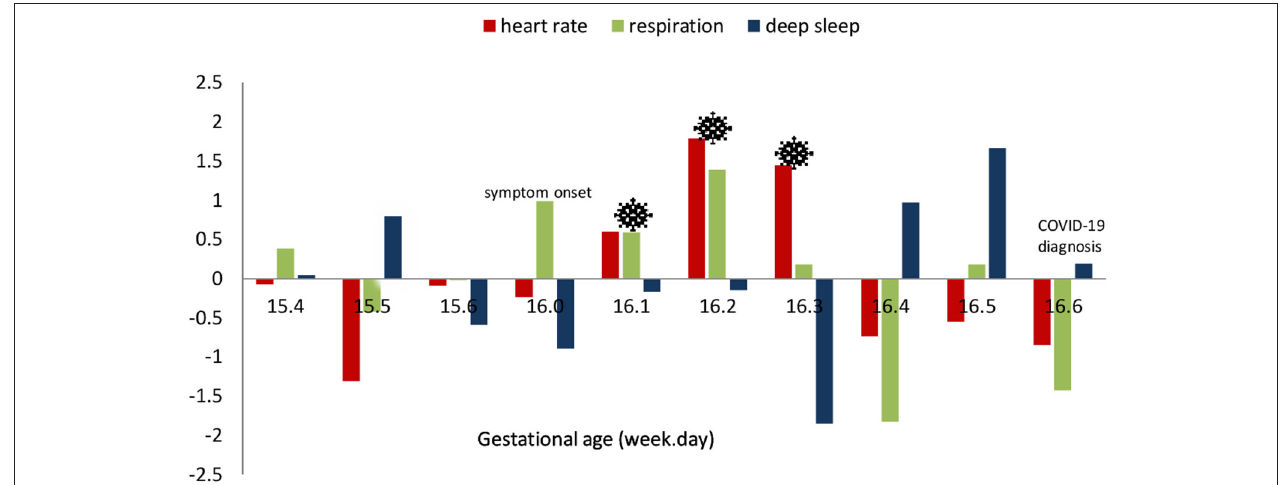
FIGURE 1 | Case I: daily standardized scores of selected physiological parameters surrounding the period of COVID-19 infection.